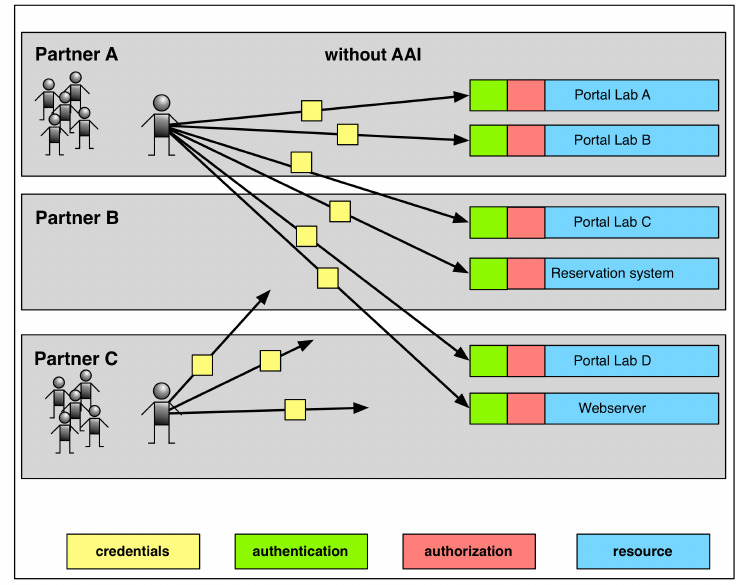
Figure 1. Traditional non-federated